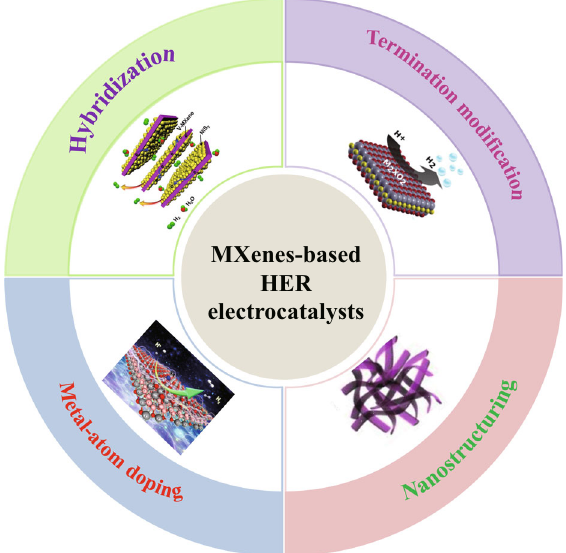
Fig. 11 Strategies for optimizing the MXenes-based HER electro- catalysts. Schematic diagram summarizing different approaches for optimizing the MXenes-based